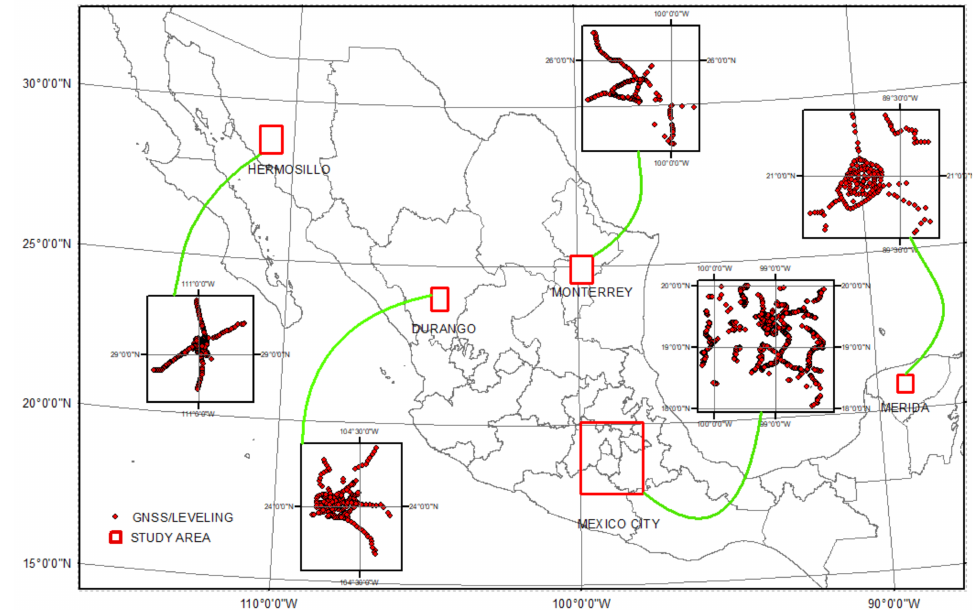
Figure 1. Locations of urban geodetic networks recently stablished by INEGI in Mexico. The cities names are: Hermosillo with 337 stations, Durango with 250 stations, Merida with 182 stations, Monterrey with 166 stations, and Mexico City with 811